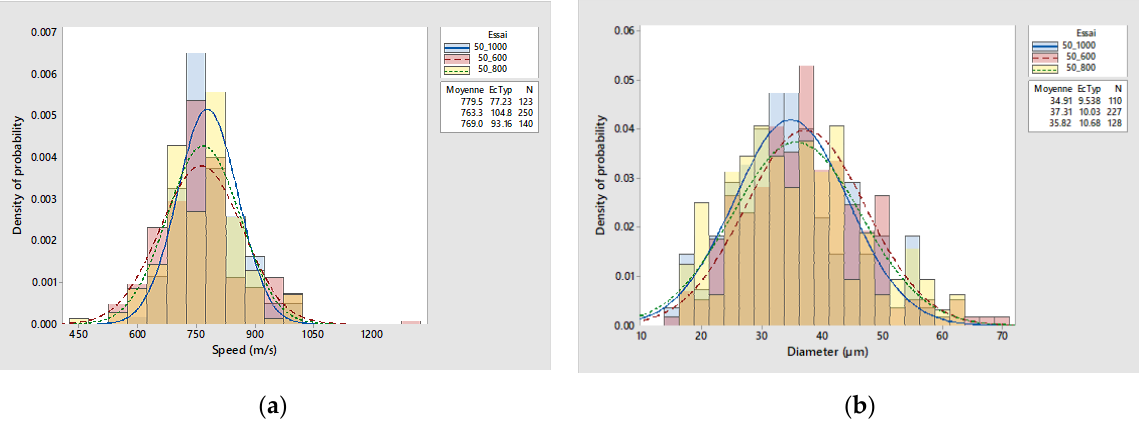
Figure 6. ( a ) Ti 3 AlC 2 particle velocities distribution; ( b ) the corresponding particle density distribution for 5 MPa gas pressure and different gas temperatures.